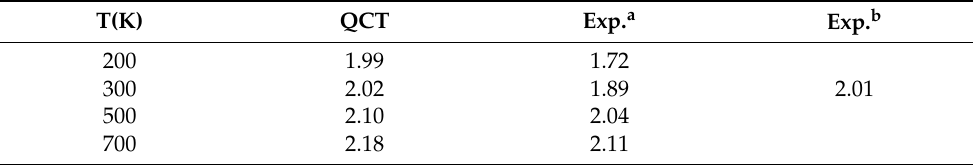
Table 4. H/D kinetic isotope effects for the CN + NH 3 reaction using the QCT/PES-2020.